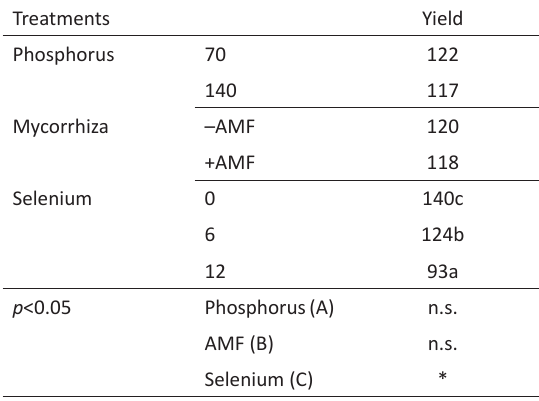
Table 2. Effect of mycorrhiza on yield (g) of lettuce grown on medium with different levels of phosphorus and selenium